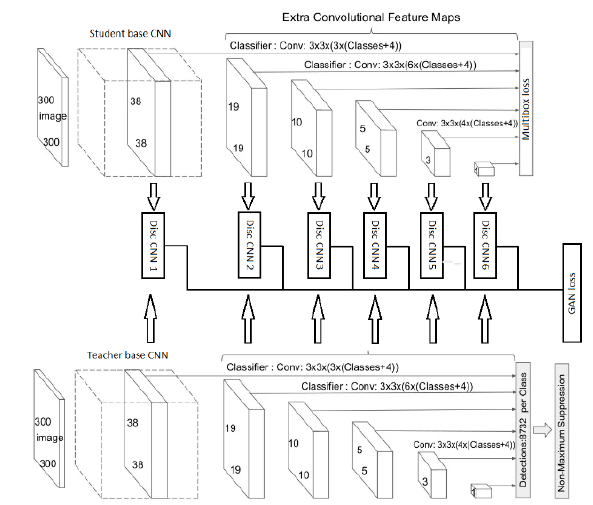
Figure 3. Proposed knowledge distilling framework.